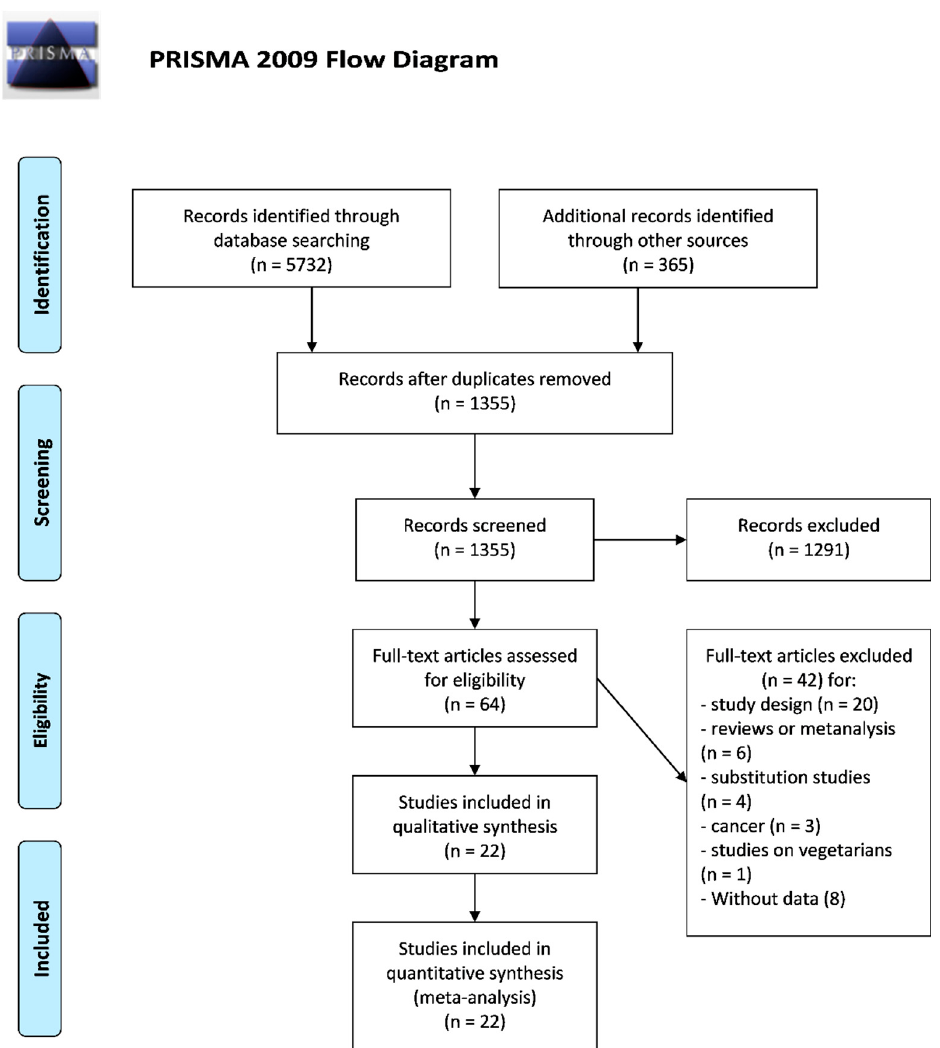
Figure 1. Preferred Reporting Items for Systematic reviews and Meta-Analyses (PRISMA) flow diagram.